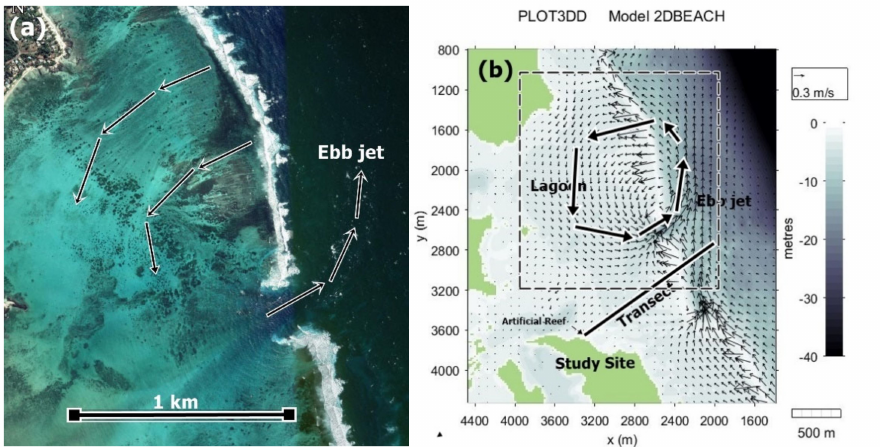
Figure 7. ( a ) Ebb jet currents from the northern reef pass are indicated by waves breaking against the opposing current. The seabed scour marks indicate flow over the reef crest and into the lagoon. ( b ) Current patterns from Model 2dBeach for the most common input waves of 1.5 m height from 100 ◦ true. Currents head over the reef crest into the lagoon and exit via the reef passes. The axis scales are metres from an arbitrary origin. The grey scale shows water depth and arrow velocity scale is shown in the top right corner. The dashed rectangle defines the region in Figure 7a. The transect is referred to in Figure 8.